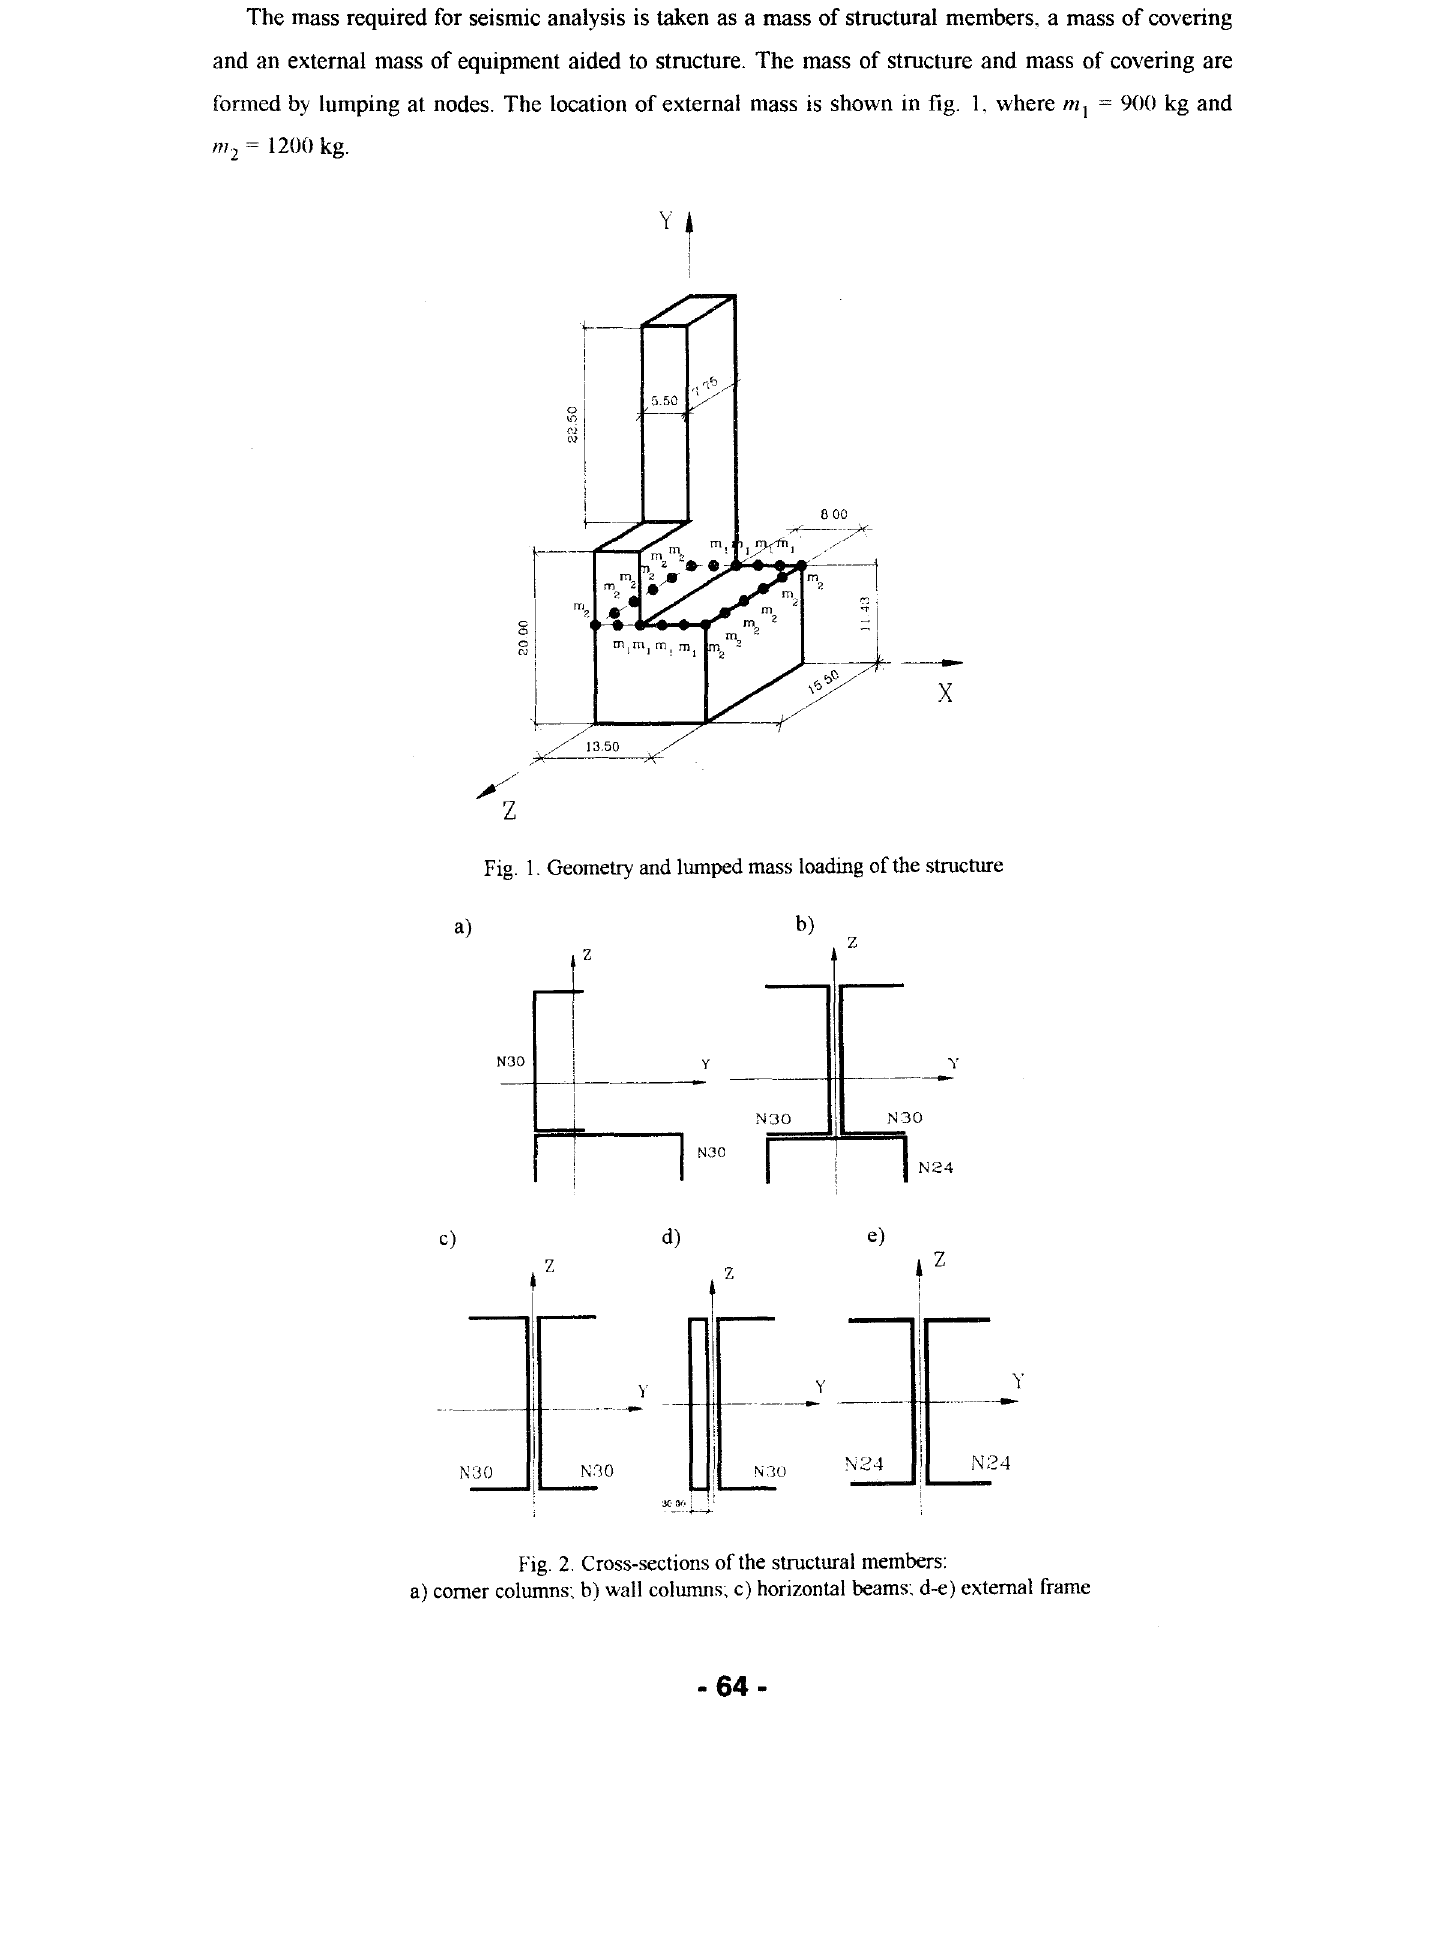
Fig. 1. Geometry and lumped mass loading of the structure